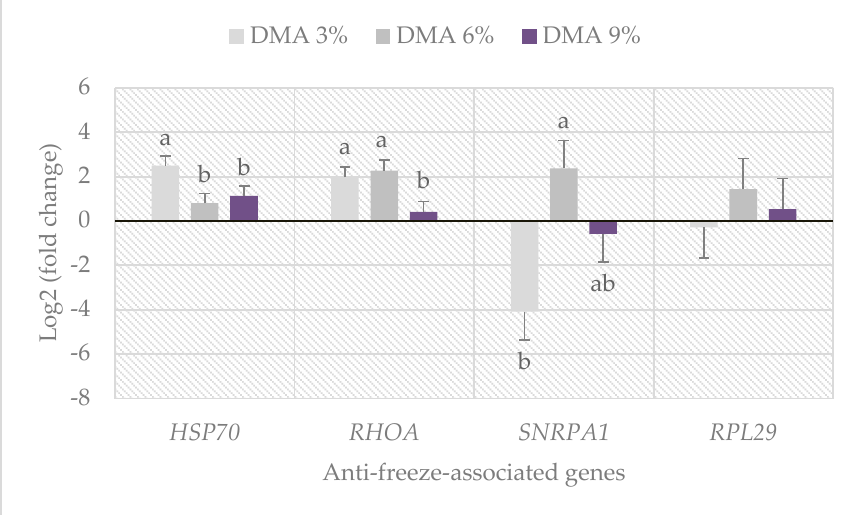
Figure 1. Effect of dimethyl acetamide (DMA) concentration in freezing extender on the anti ‐ freeze ‐ associated gene expression of rooster sperm after thawing. Bars express the means of three samples (n = 3) as log 2 (fold change) ± standard error (SE). a–b Means with different superscripts, within the same gene, are significantly different ( p < 0.05). HSP70 : heat shock protein family A, RHOA : ras homolog family member A, SNPA1 : small nuclear ribonucleoprotein polypeptide A ′ , RPL29 : ribo ‐ somal protein L29. p ‐ values of linear and quadratic effects are 0.021 and 0.038 for HSP70 , 0.016 and 0.036 for RHOA , 0.032 and 0.005 for SNPA1 , and 0.573 and 0.314 for RPL29 , respectively.